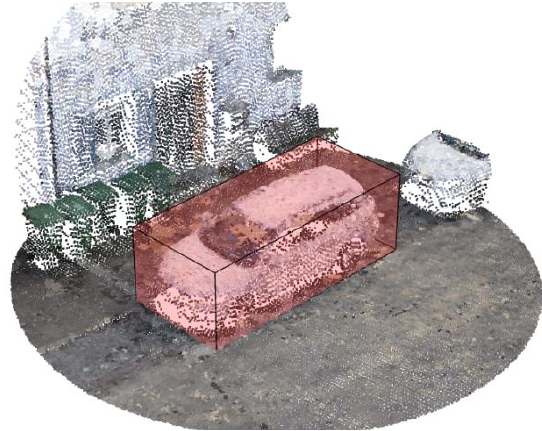
Figure 7. Example of a vehicle approximated with a MBB